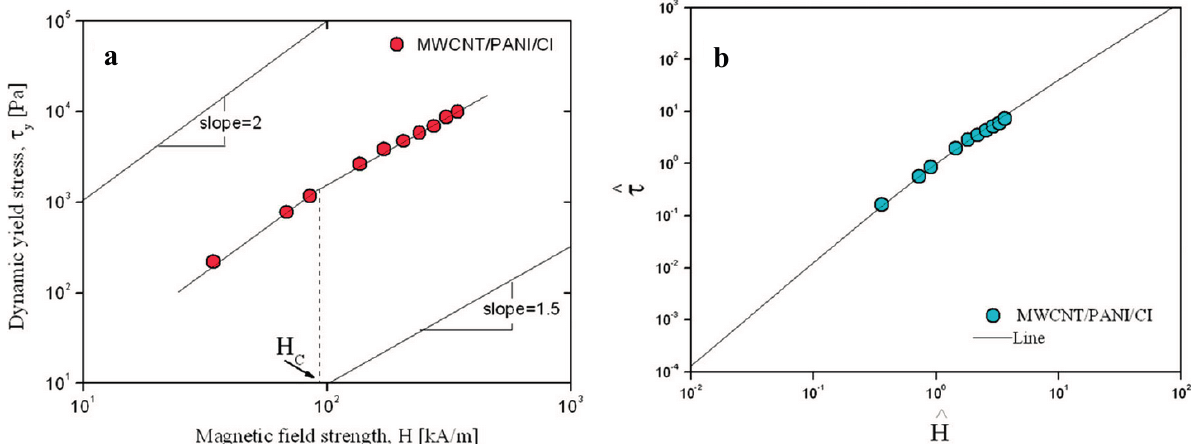
Figure 7. ( a ) Dynamic yield stress vs. magnetic field strength and ( b ) τ MWCNT/PANI/CI-based MR suspension (Reprinted with permission from [76], copyright 2004 American Chemical Society).